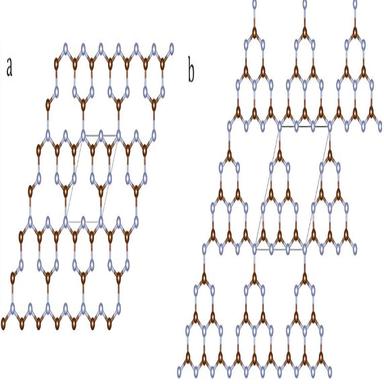
Atomic structure of (a) triazine g-C3N4 (g-CN1) and (b) tri-s-triazine g-C3N4 (g-CN2). The unit cells are indicated by rhombuses. Carbon atoms are depicted in brown and nitrogen atoms are depicted in grey.